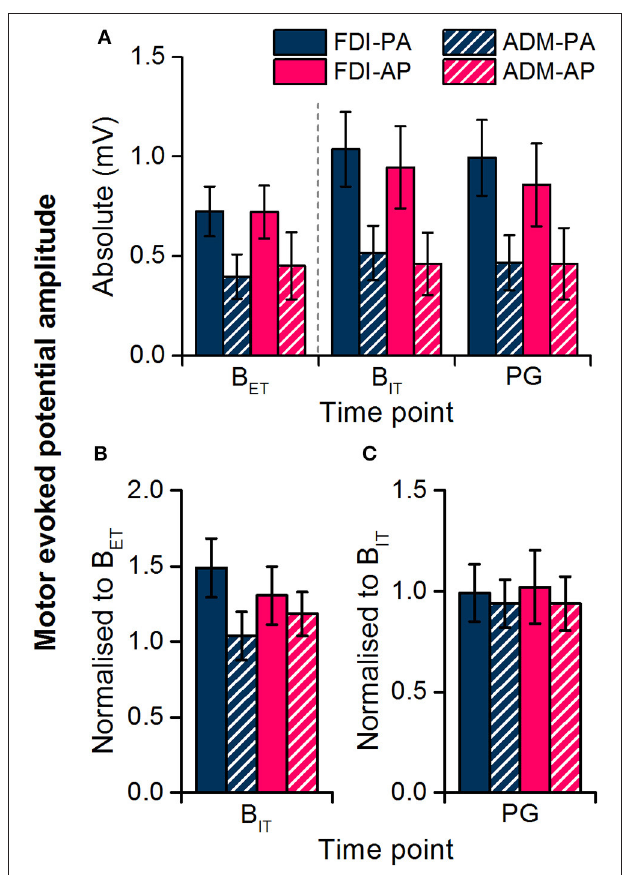
The FDI:ADM MEP ratio remained constant over time ( Figure 4 ) confirming that the modulation of MEP amplitudes across time points was not specific to the FDI. In the statistics the ANOVA showed no main effect of current direction [ F (1, 19) = 1.258, P = 0.276] or time point [ F (1, 19) = 0.016, P = 0.900], or